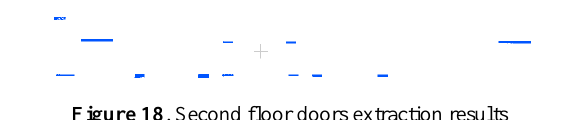
Figure 18 . Second floor doors extraction results